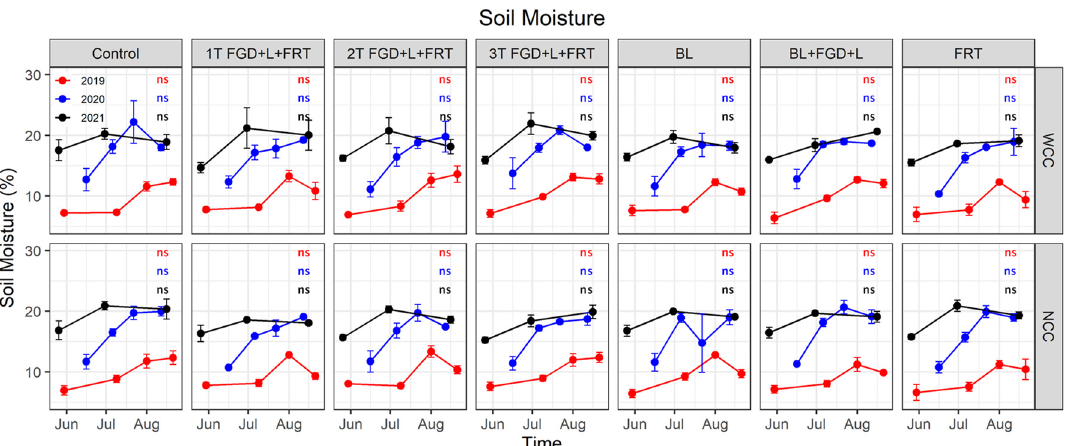
Figure 4. Soil moisture at sampling events. Red, blue and black lines represent soil moisture in 2019, 2020 and 2021, respectively. Solid cycles are the mean of replicates, and error bars are standard errors (n = 3). Red, blue and black letters show the results of Tukey’s multiple comparison tests for 2019, 2020 and 2021, respectively, with no letter in common denoting significant differences at α = 0.05 (ns: no significant difference). WCC: with cover crop; NCC: no cover crop.